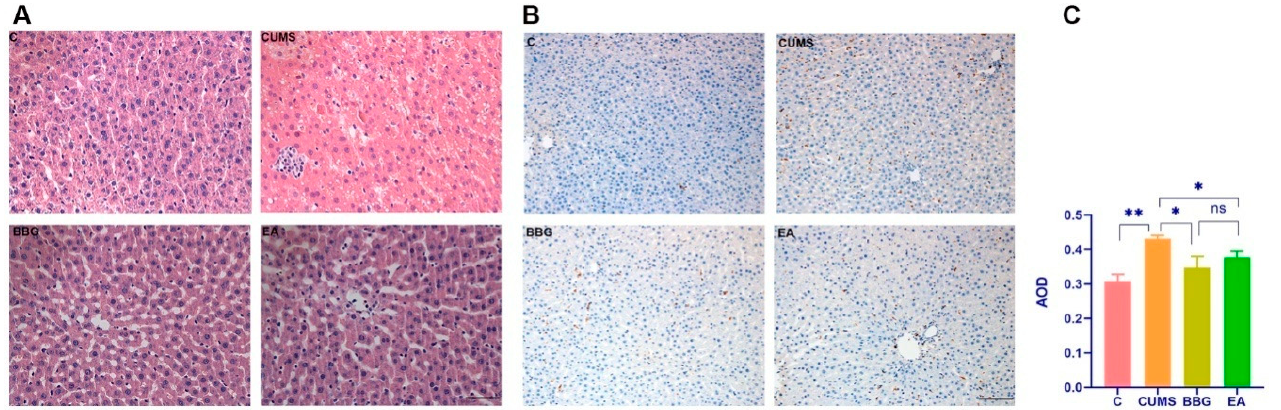
Figure 4. Effects of EA on the liver: ( A ) HE staining of liver, ( B ) CD68 expression in right liver lobe, and ( C ) comparison of CD68 expression in right liver lobe. * p < 0.05, ** p < 0.01. The scale bars in A = 50 µ m, and in B = 100 µ m.